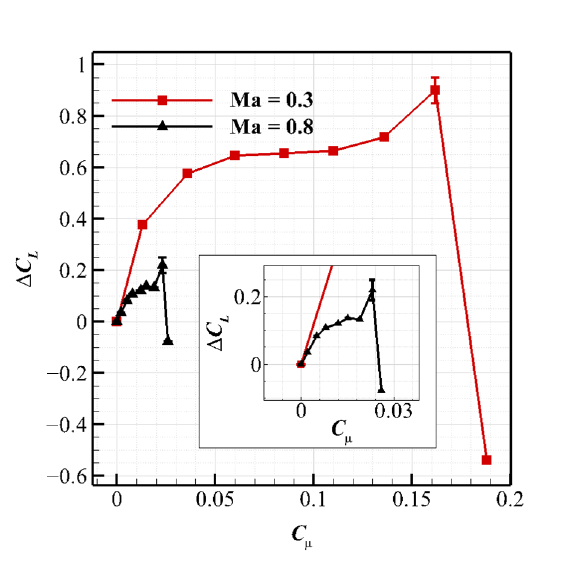
Figure 11. Lift coefficient augmentation for a range of momentum coefficients under steady